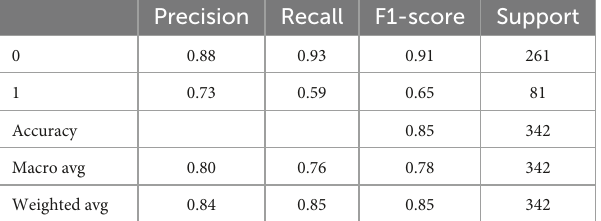
TABLE 7 SVM model quality before